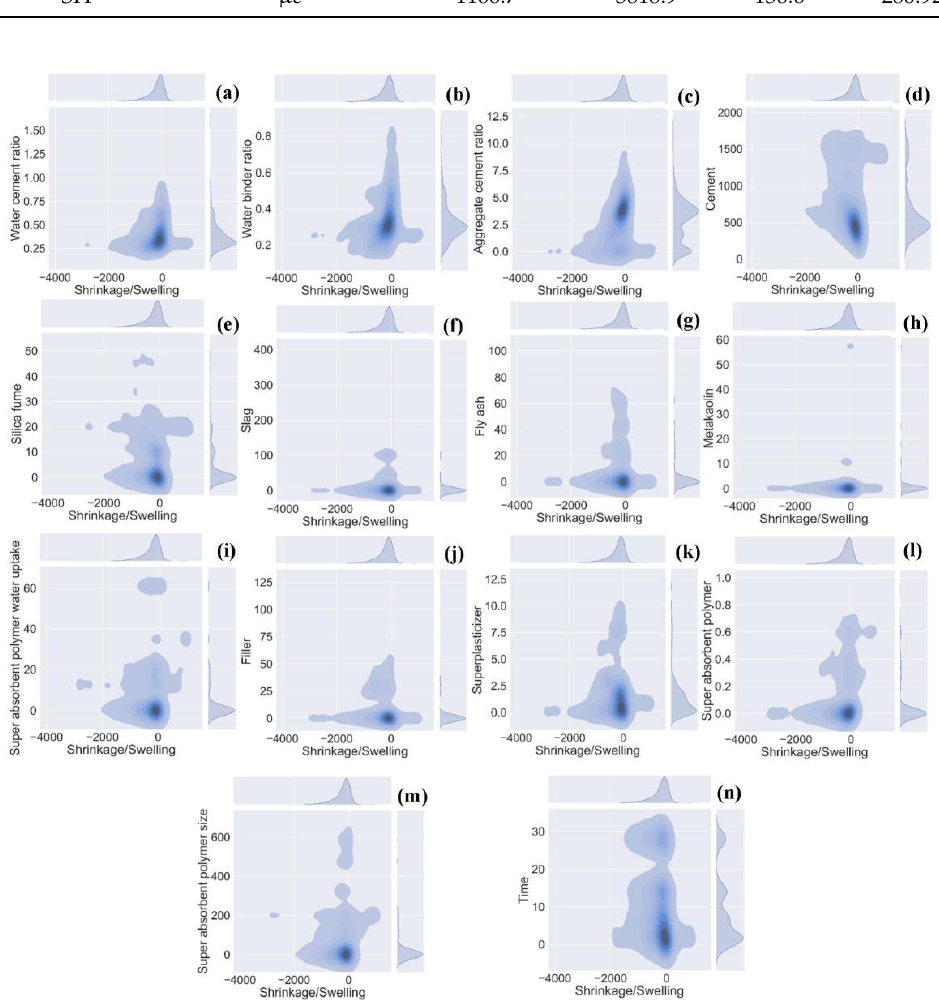
Figure 1. Frequency distribution of input parameters; ( a ) Water cement ratio; ( b ) Water binder ratio; ( c ) Aggregate cement ratio; ( d ) Cement (kg/m 3 ); ( e ) Silica fume (% cement mass); ( f ) Slag (% cement mass); ( g ) Flyash (% cement mass); ( h ) Metakaolin (% cement mass); ( i ) Super absorbent polymer water intake g/g of SAP; ( j ) Filler (% cement mass); ( k ) Superplasticizer (% cement mass); ( l ) Super absorbent polymer (% cement mass); ( m ) Super absorbent polymer size µ m; ( n ) Curing time